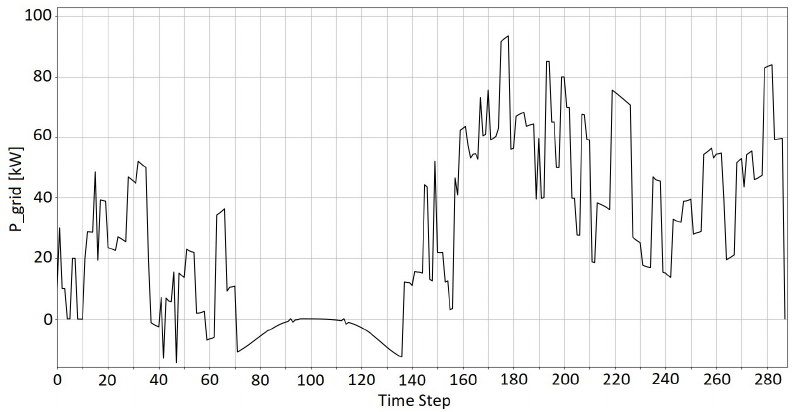
Figure 8. Power Grid Simulation